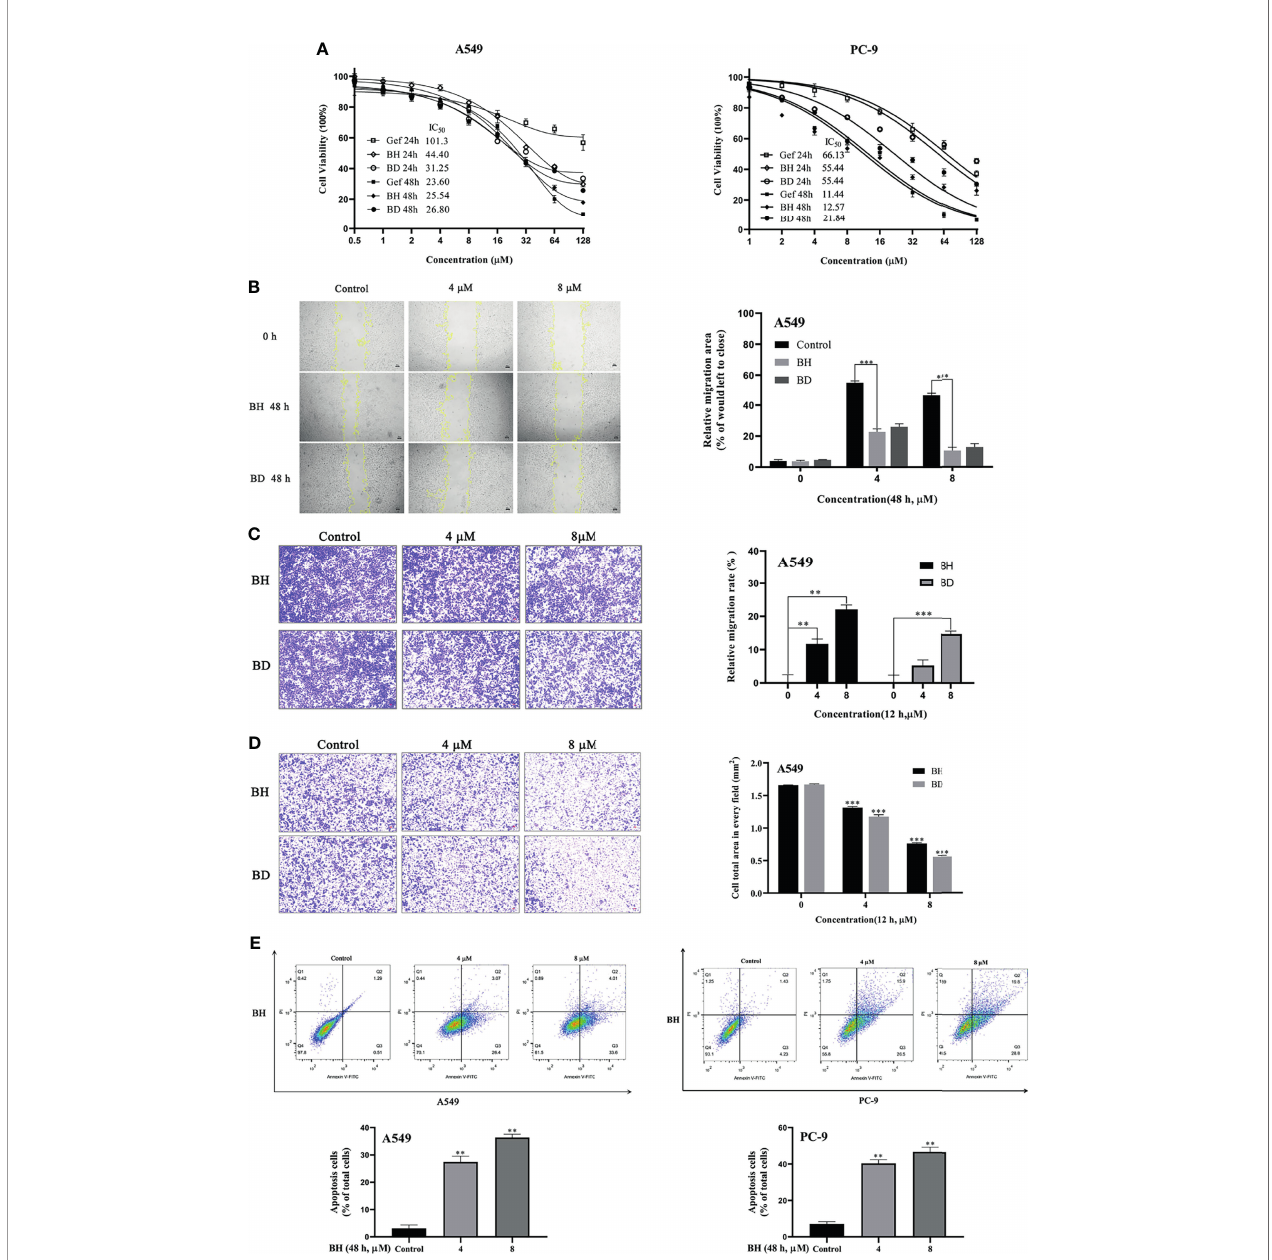
FIGURE 2 | Antitumor effects of BH and BD against non-small cell lung cancer (NSCLC) cell lines in vitro . (A) The proliferation of cells as well as the IC 50 was determined in A549 and PC-9 cells after 24 and 48 h. (B) Cell migration of A549 cells was detected by wound healing assay. (C, D) Transwell migration and Matrigel invasion assays of A549 cells were measured. (E) The apoptosis of A549 and PC-9 cells was measured using fl ow cytometry 48 h after treatment with BH. All experiments were independently conducted at least three times and showed representative data. “ ** ” represents BH group vs. the Control group (**p < 0.01, ***p <